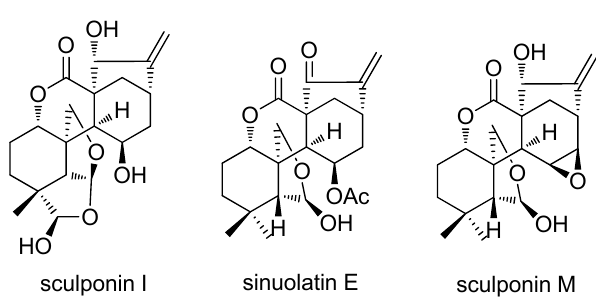
Figure 1. Natural enmein-type ent -kaurane diterpenoids.